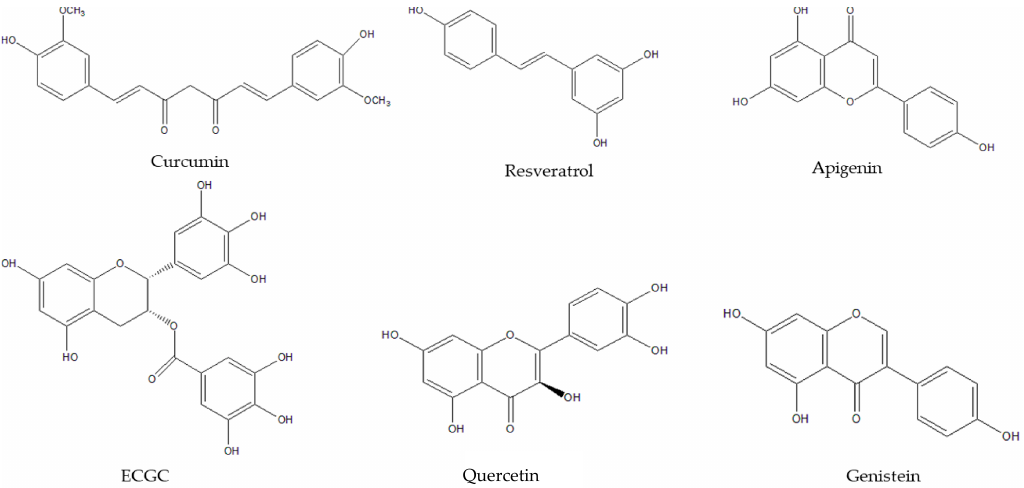
Figure 3. Structure of some of the most common polyphenolic compounds. They contain one or more benzene rings joined to hydroxyl